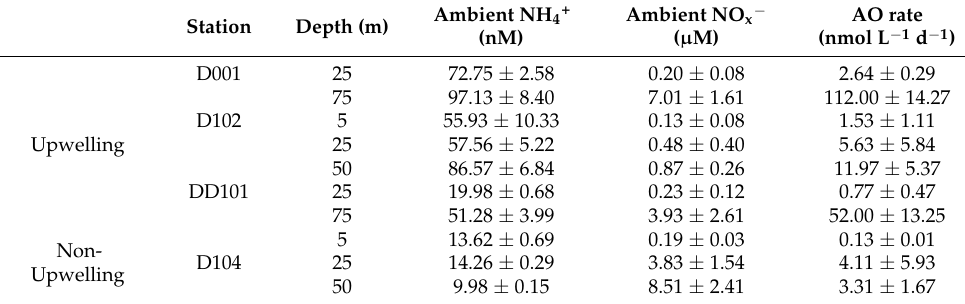
Table 2. The vertical ambient NH 4+ , NO x − concentrations and ammonia-oxidizing rates in upwelling and non-upwelling regions in the eastern Hainan Island during summer. The errors represent standard